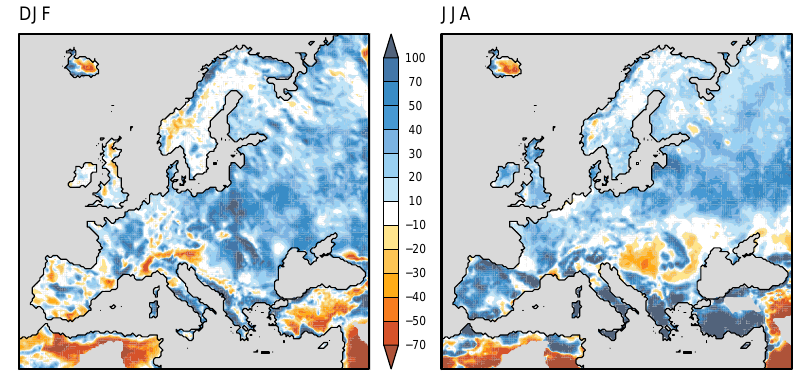
Figure 4. Spatial BIAS of precipitation (%) over the sample I K14 for DJF (left) and JJA (right) for RMIB-UGent-11. Compare to Fig. 3 of Kotlarski et al.